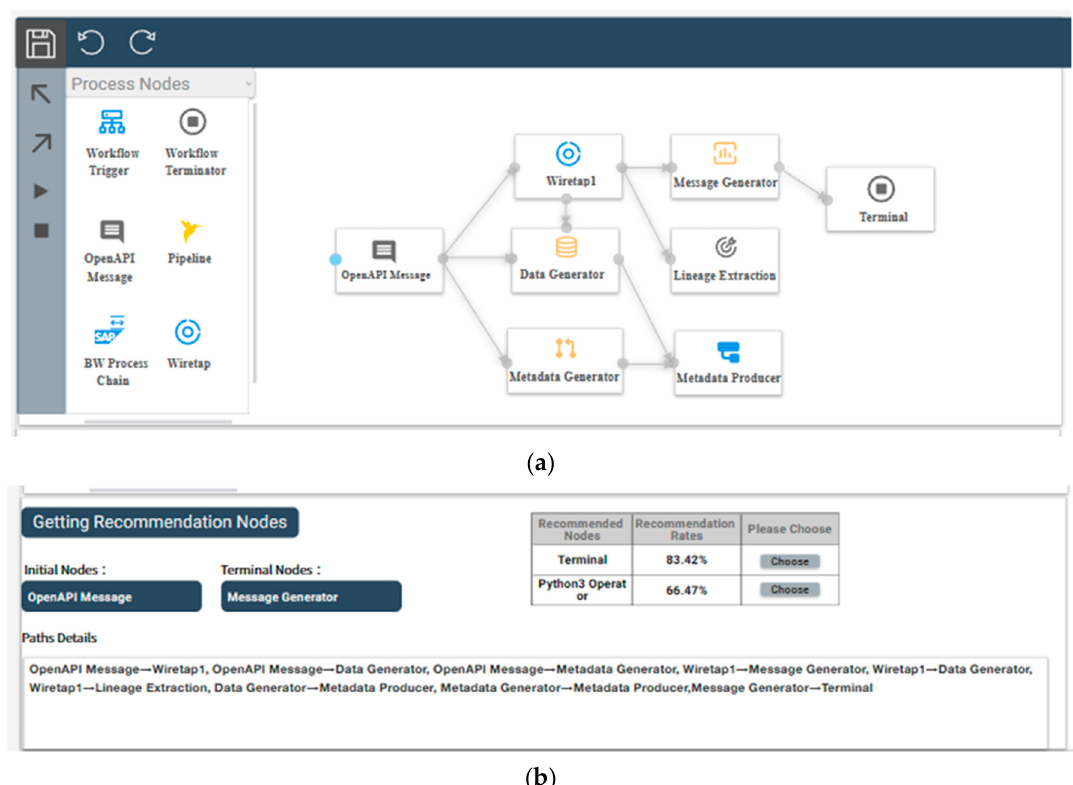
Figure 11. Visual prototyping system: ( a ) process builder module; ( b ) recommendation and data interaction module.